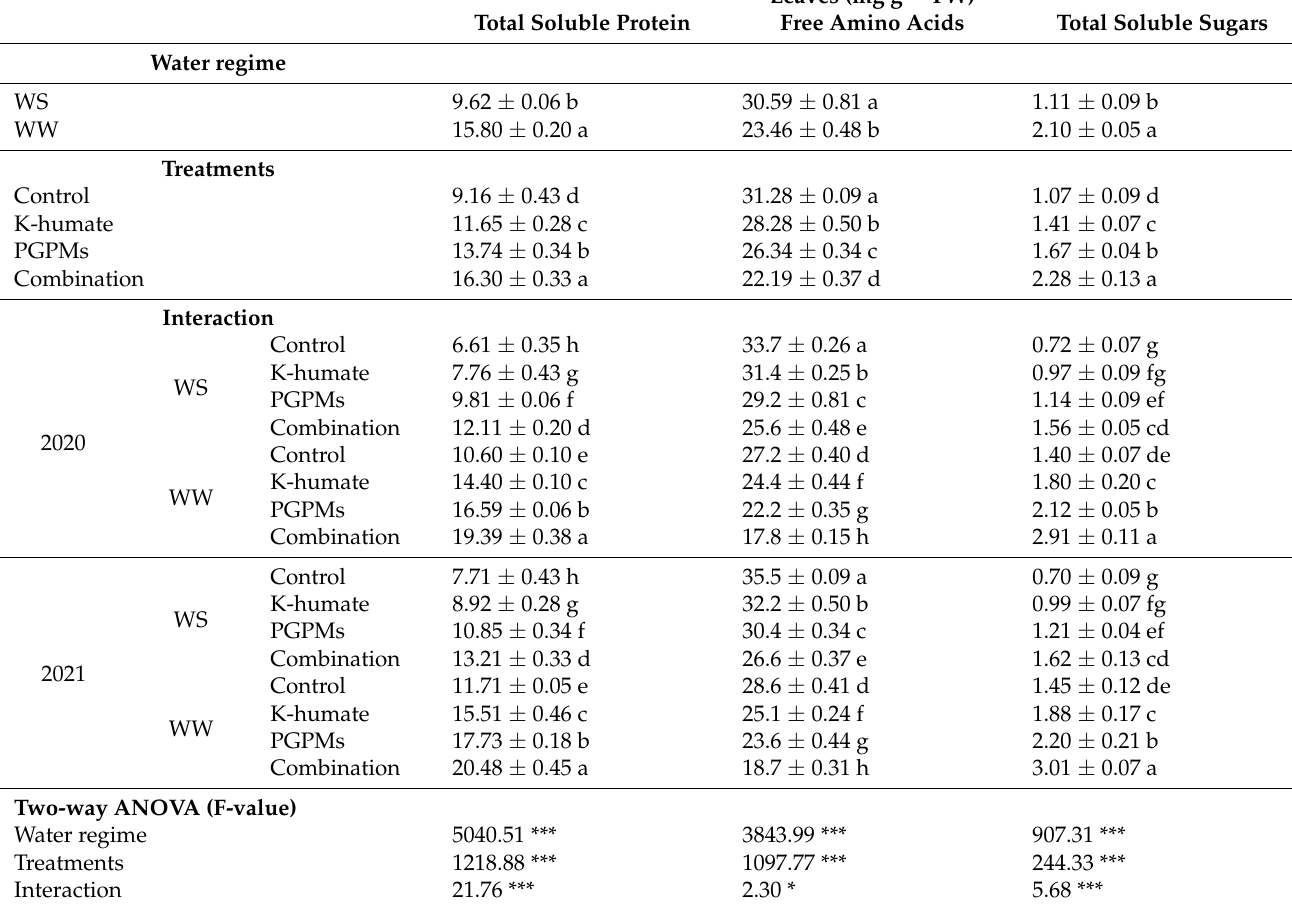
Table 2. Some biochemical features of soybean leaves ( Glycine max L. cv. Giza 111) which were cultivated in salt-affected soil and treated with plant growth-promoting microbes (PGPMs; Bradyrhi- zobium japonicum (USDA 110) and Trichoderma harzianum ), potassium humate (K-humate), and their combination under two water regimes (WS: water deficit regime and WW: well-watered regime) during two consecutive